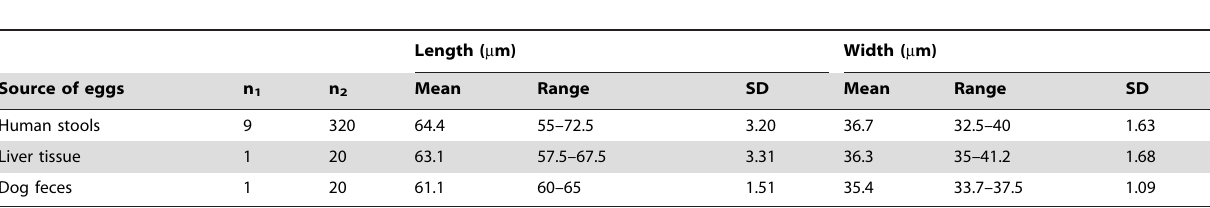
Table 1. Morphometric parameters of the eggs of C. hepaticum from human stools, peccary liver tissue and dog feces.